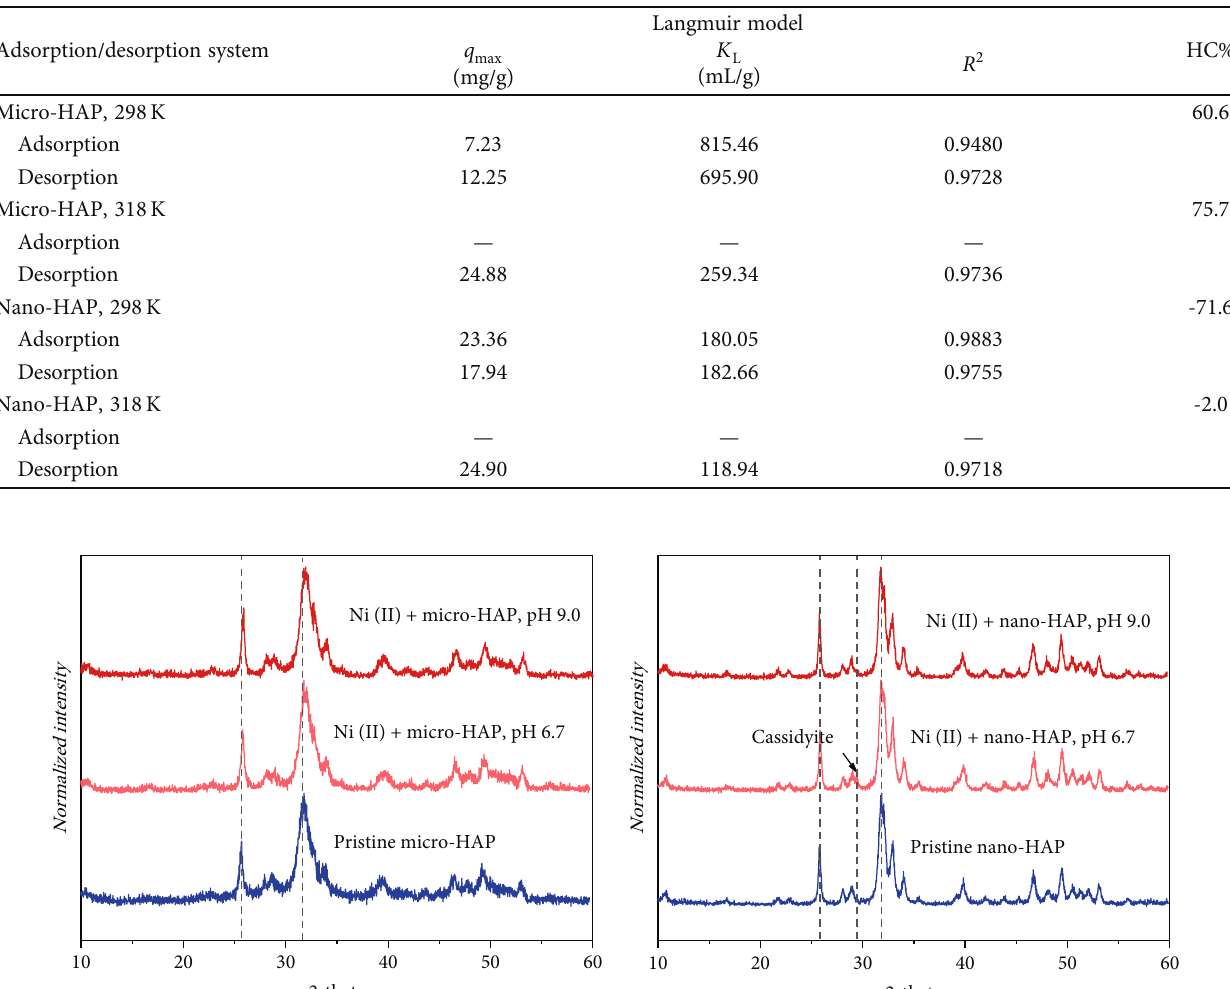
Table 2: The Langmuir parameters of Ni(II) sorption/desorption and sorption-desorption hysteresis (HC%) on micro-HAP and nano-